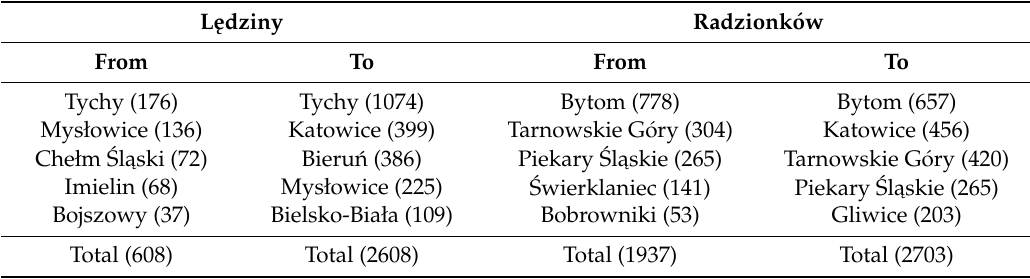
Table 2. Commuting to work in L˛edziny and Radzionk ó w (2016). The most important interlinks. Own elaboration on the base of